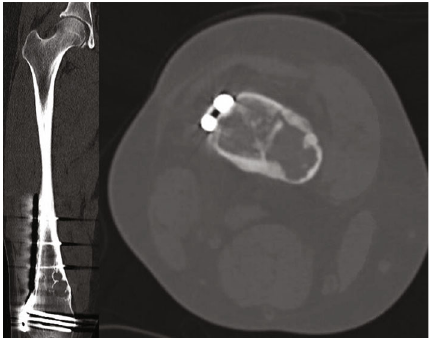
Figure 1: AP and lateral radiographs of the right knee demonstrating a pathologic fracture of the right distal femur. The lesion has characteristics consistent with nonossifying fi broma: lytic, cortically based lesion.